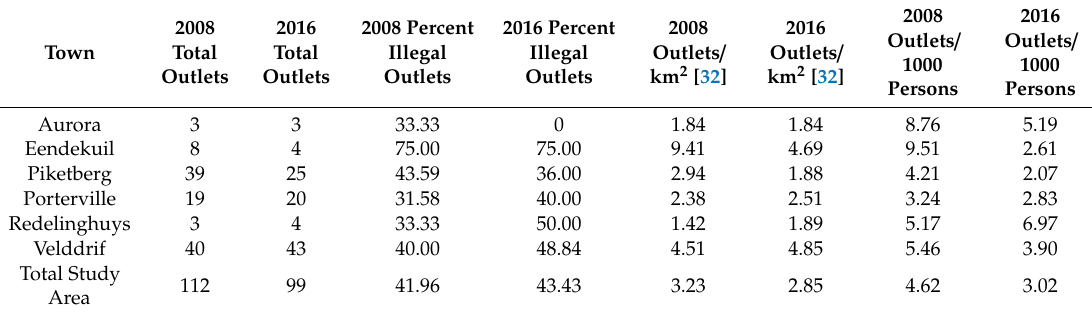
Table 2. Alcohol outlet and density